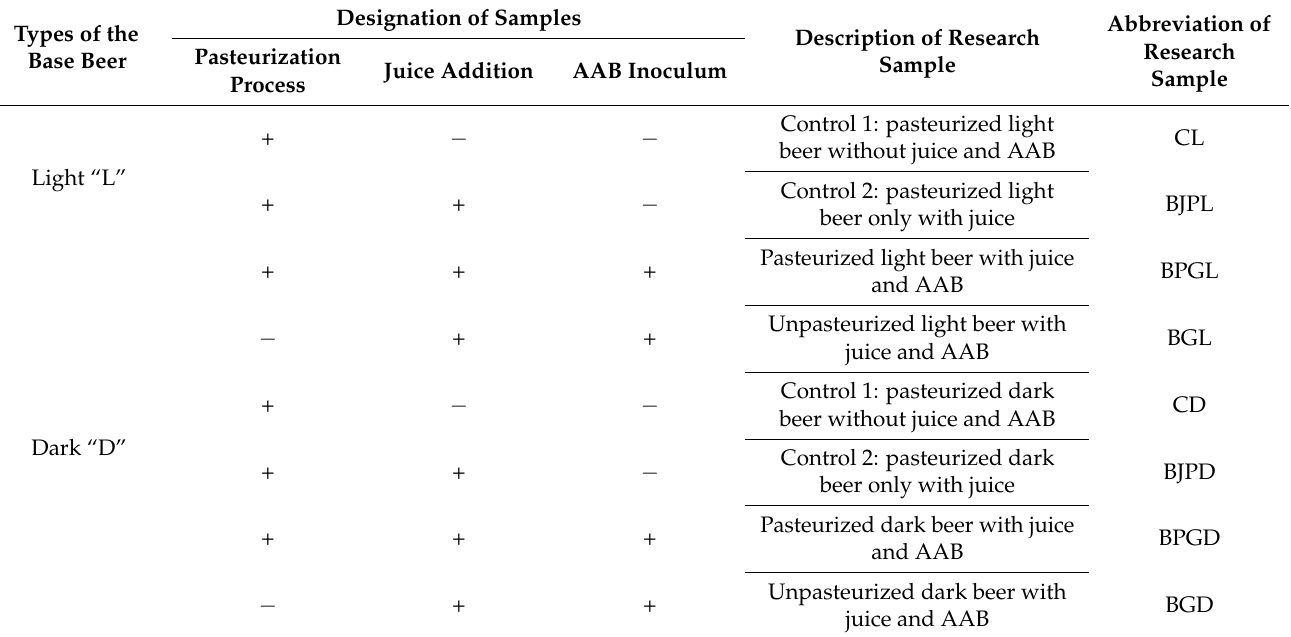
Table 1. Variants of study beer beverages and their